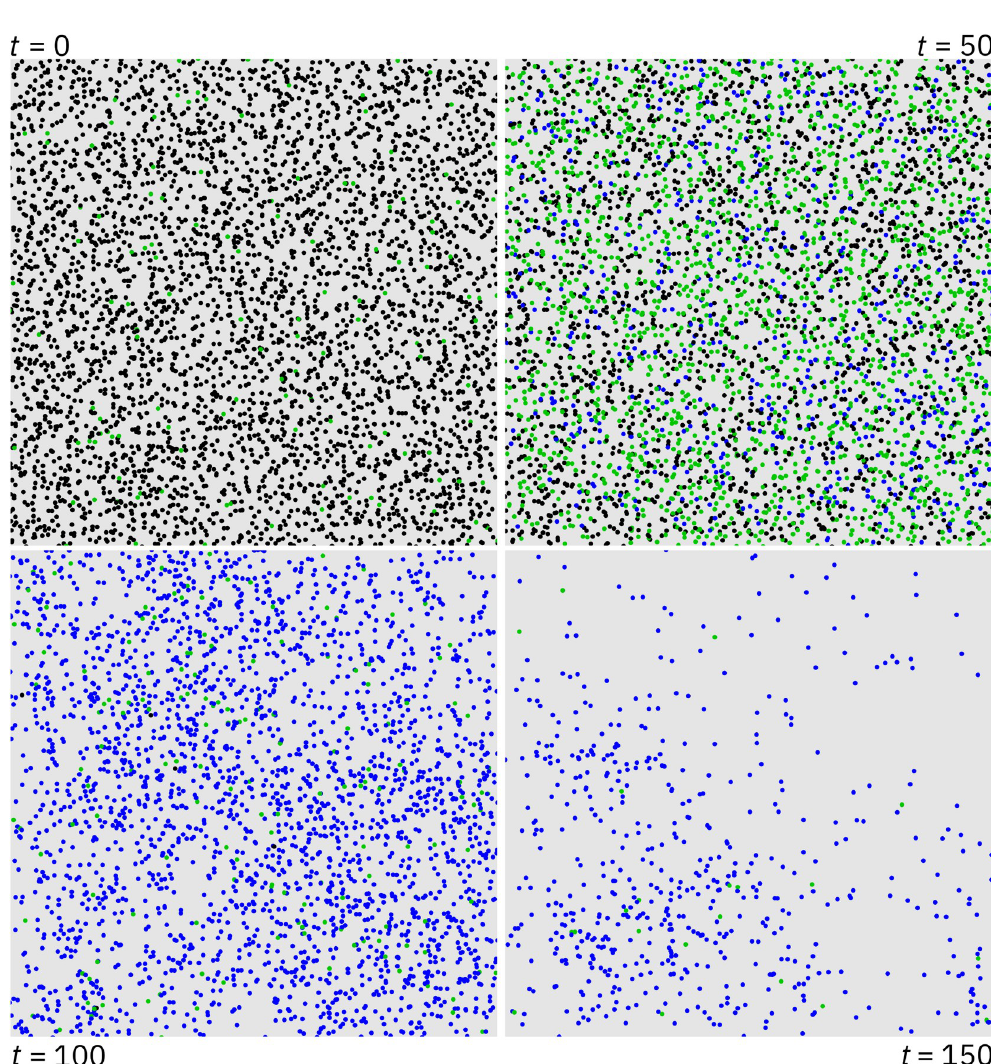
Fig 5. Gene drive spread over time for the drive targeting female fertility. A series of snapshots showing the progress of a single simulation of the homing drive with a female fertility target using default parameters and a drive efficiency of 95%. Black dots are wild type, green dots are drive/wild-type heterozygotes, and blue dots are drive homozygotes. The upper left panel depicts the time step at which the drive was introduced to the population. At first, the drive rapidly spreads through the population (upper right). After the drive has reached a sufficient frequency, the population dwindles in size (lower left) until almost all possible pairings only produce sterile offspring (lower right), leading to population elimination shortly